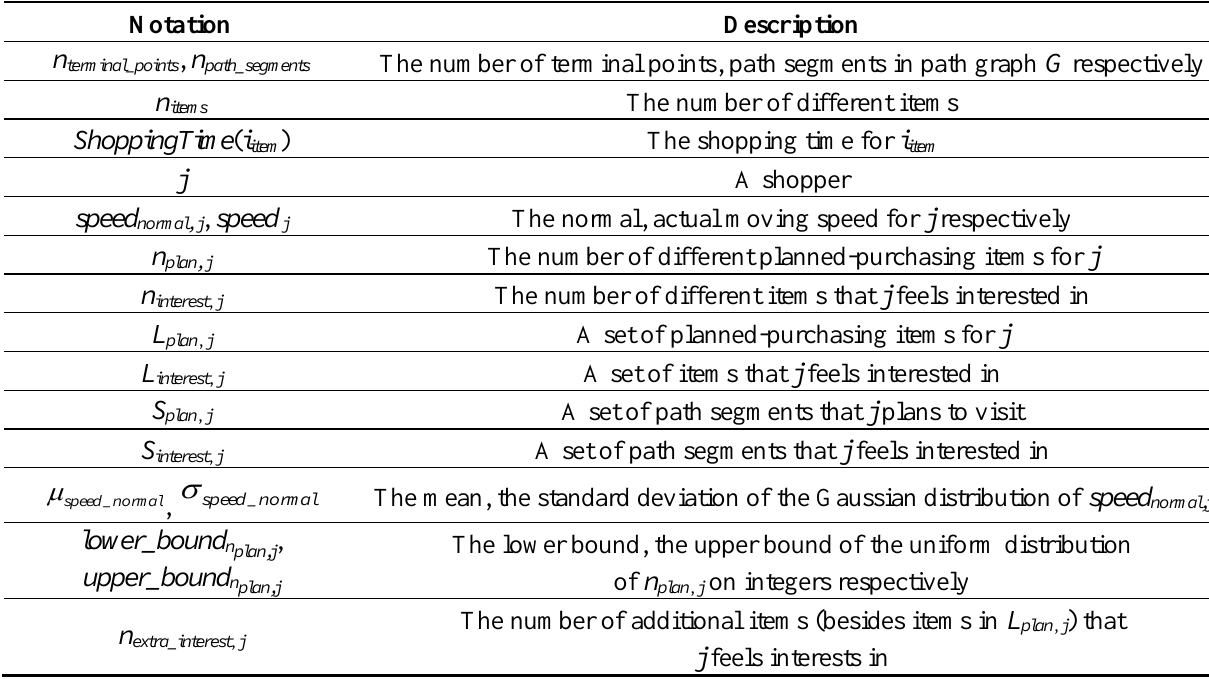
Figure 8. Flow diagram for generating a shopping transaction path. Table 4. Meaning of various variables in our